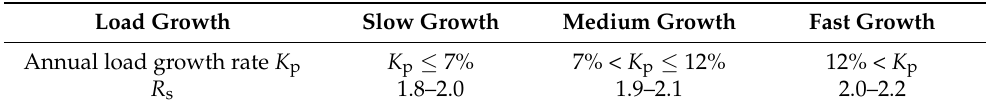
Table 8. Capacity load ratio R s (110–10